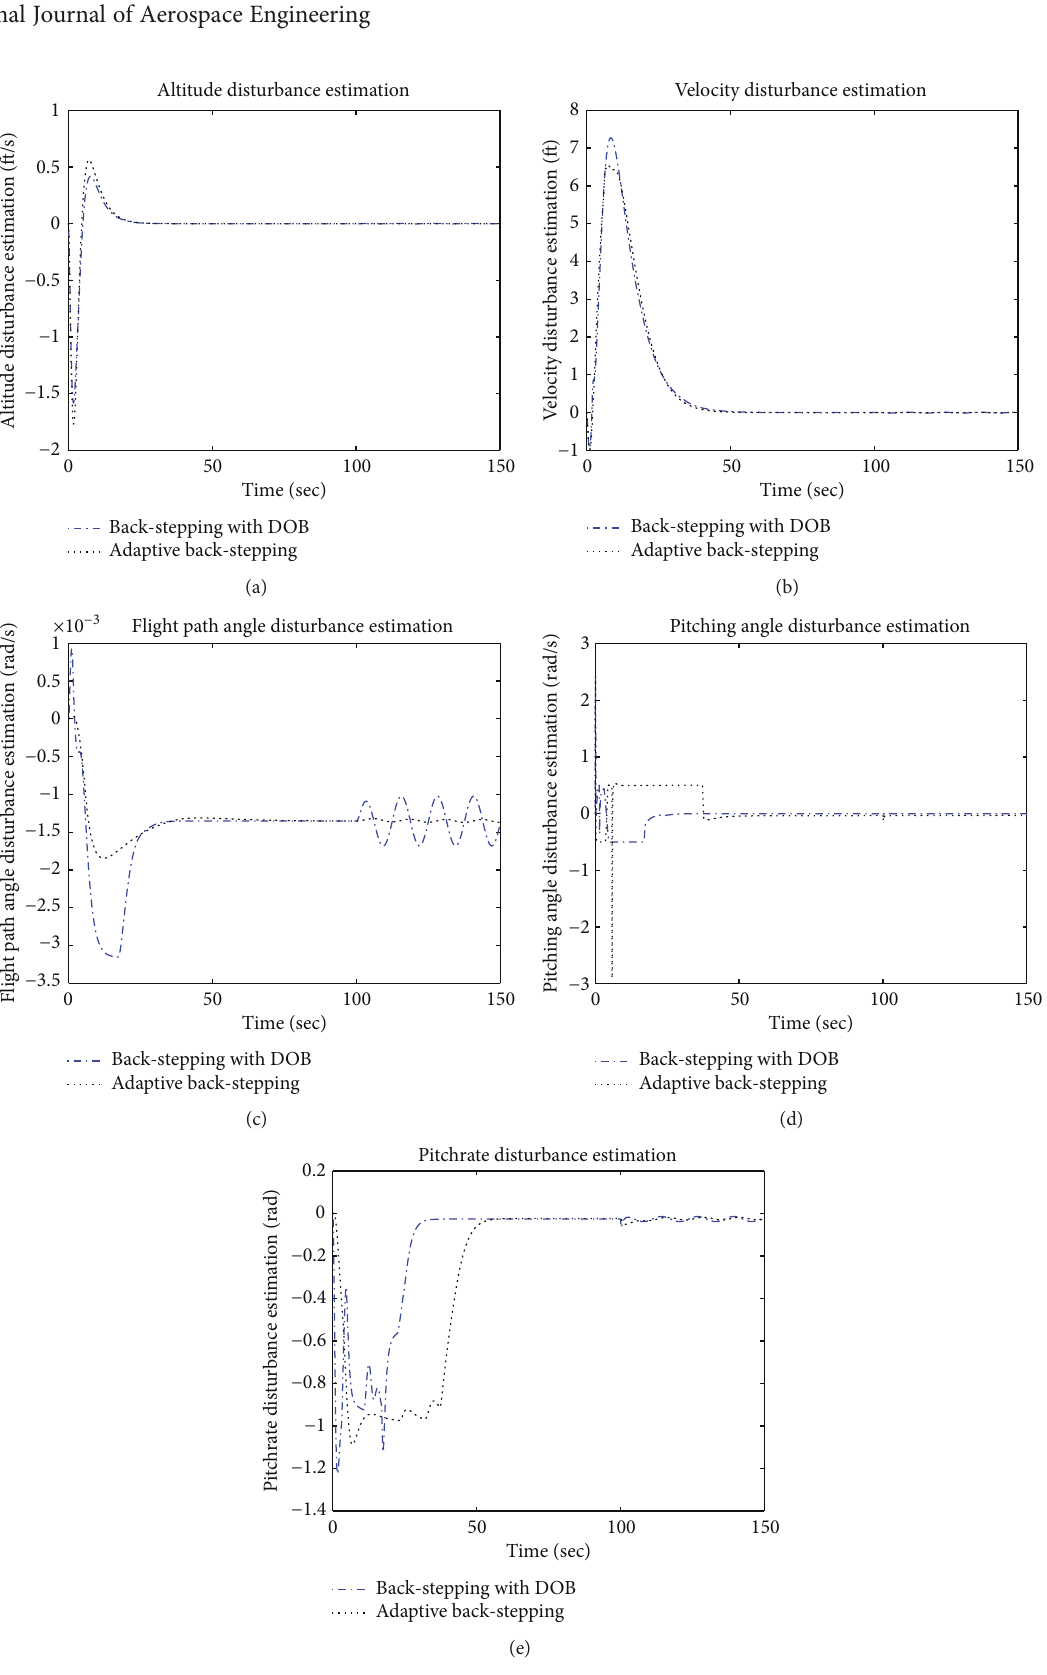
Figure 8: Lumped disturbance estimated by nonlinear disturbance